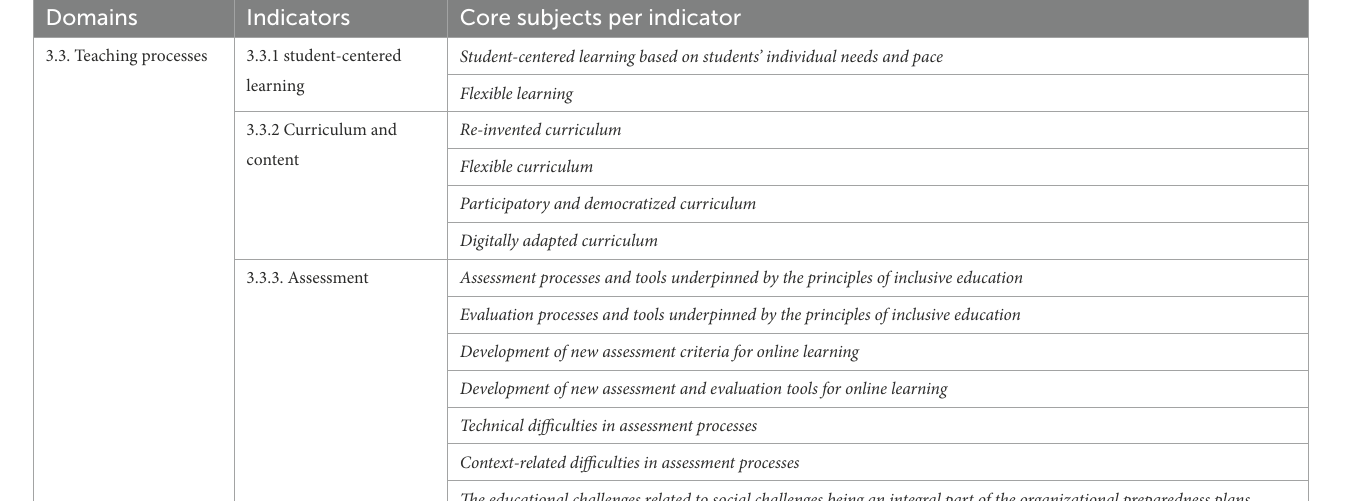
TABLE 4 Domain of teaching process.